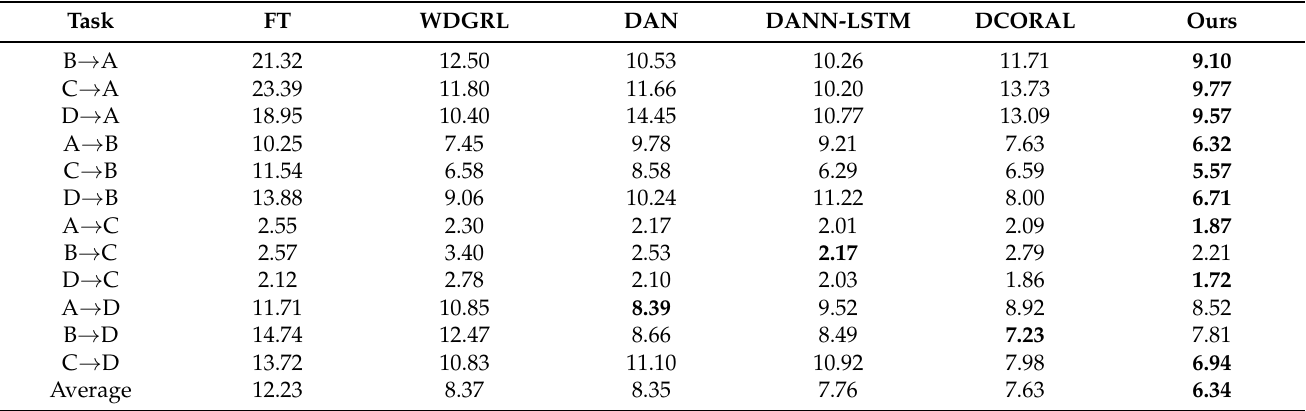
Table 4. MAE Performance. The best performance of each task is highlighted in bold.